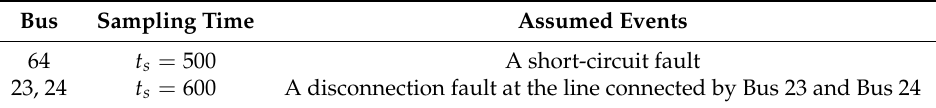
Table 3. A multiple event with two constituent components assumed in Case